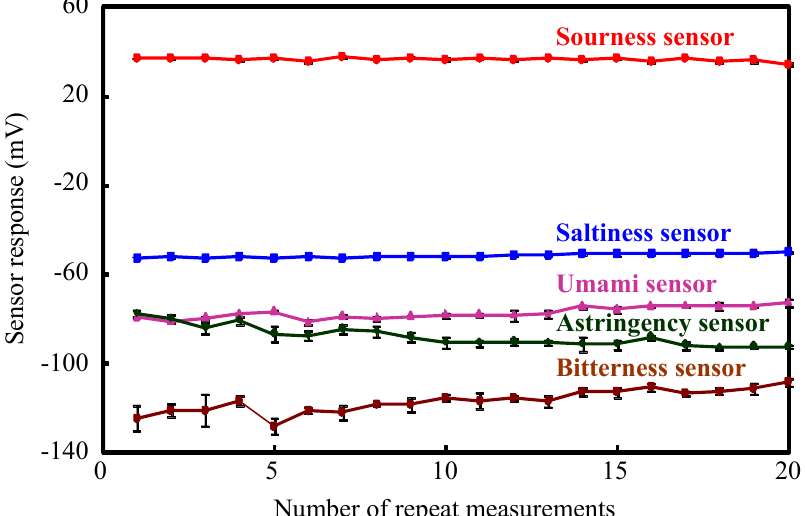
Figure 4. Repeatability of measurement of each taste substances by the sensor chips. Data are expressed as mean ± SD ( n = 4). Taste substance of saltiness, sourness, umami, bitterness and astringency were used 300 mM KCl in 30 mM tartaric acid, 3 mM tannic acid in 30 mM KCl, 10 mM MSG, 0.01 vol% iso-alpha acid in reference solution and 0.05 wt% tannic acid,